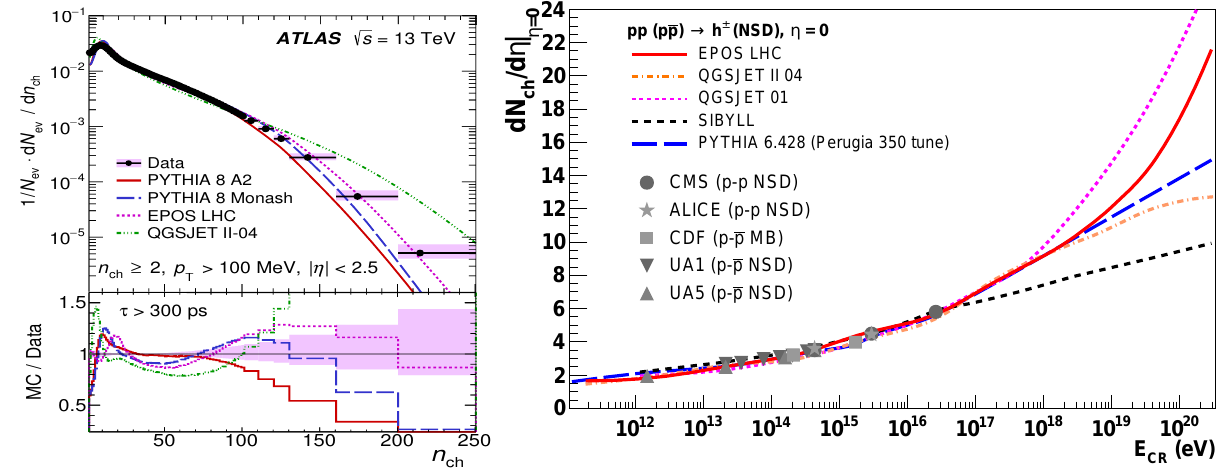
√ s = 13 TeV measured by ATLAS compared to the